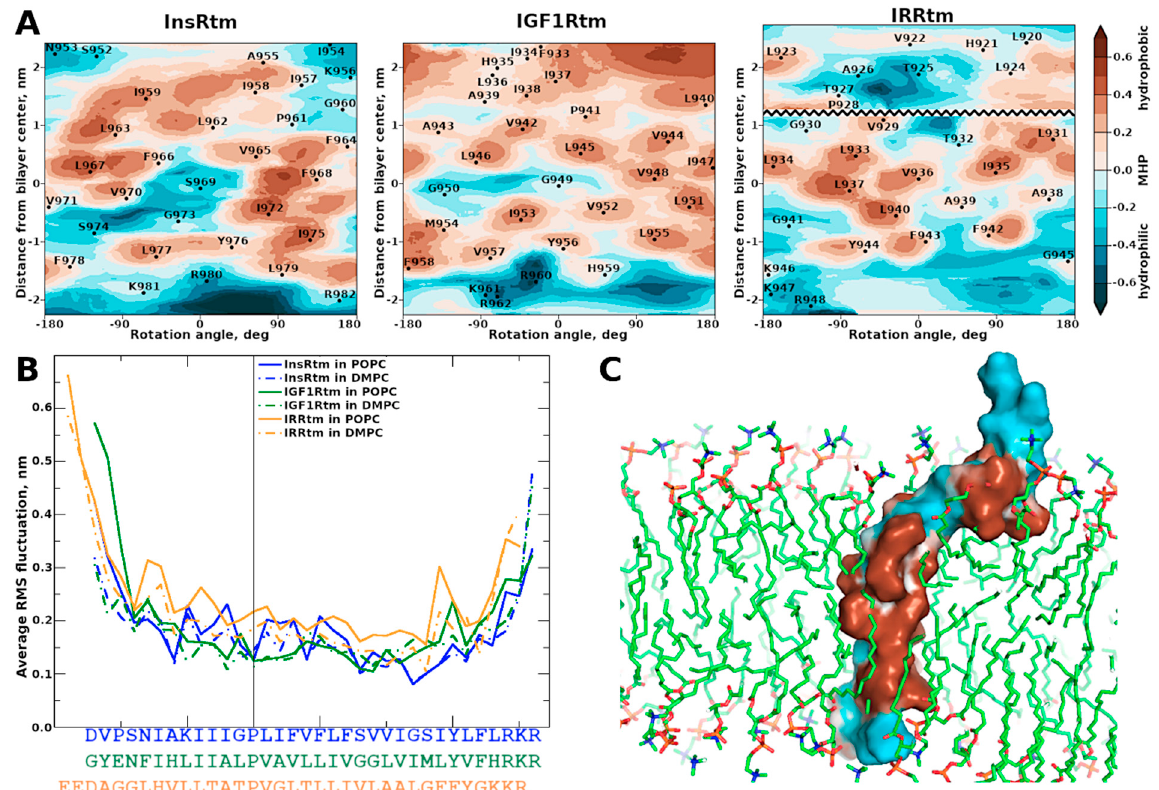
Figure 2. Hydrophobic properties and dynamics of NMR-derived structures of InsRtm, IGF1Rtm, and IRRtm in explicit lipid bilayers. ( A ) Two-dimensional MHP maps of TMD helices: cylindrical projections of the surface MHP [41,42] averaged over MD trajectories in the POPC bilayer. X- and Y-axes correspond to the rotation angle around the helix axis and the shift along it, respectively. Hydrophobic surface regions are shown in brown, and hydrophilic ones—in cyan. In the case of IRRtm, the map is divided into two parts corresponding to the n- and c-term helices separated by intramembrane proline P 928 . The MHP scale is shown on the right. MHP values are given as log p values, where p is the octanol-1/water partition coefficient. ( B ) Per-residue root-mean square fluctuations (RMSF) averaged over MD trajectories for InsRtm (blue), IGF1Rtm (green), IRRtm (yellow) in POPC and DMPC bilayers. ( C ) Representative TMD structure (of IRRtm) after MD-relaxation in explicit lipid bilayer (POPC). The molecular surface of TMD is colored according to MHP values.